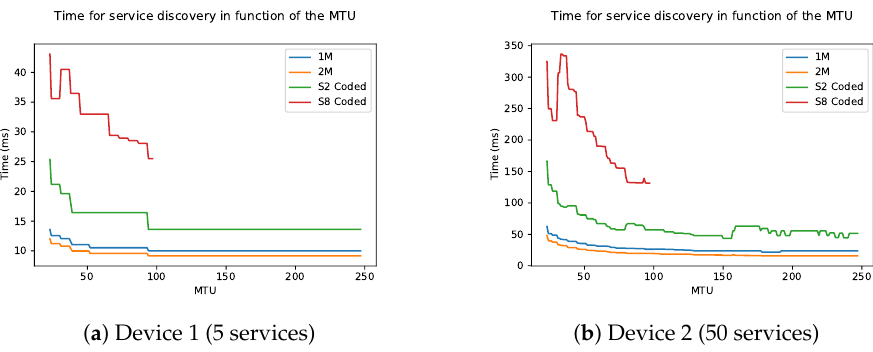
Figure 16. Time of the RSDP as a function of the MTU of two devices: ( a ) Device 1 and ( b ) Device 2.